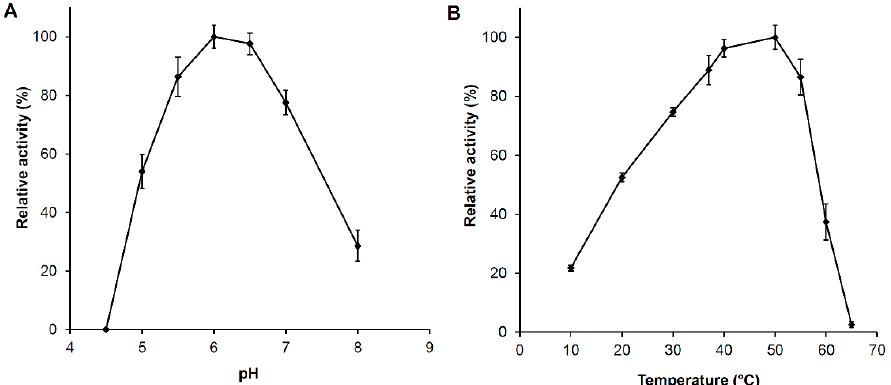
Figure 5. Ph Nah20A pH and temperature optima. The effect of pH ( A ) at 37 °C and the temperature at pH 6.0 ( B ) on initial rates of the hydrolysis of 2 mM p NPGlcNAc are both expressed as relative activity (%) from optimal activity values.